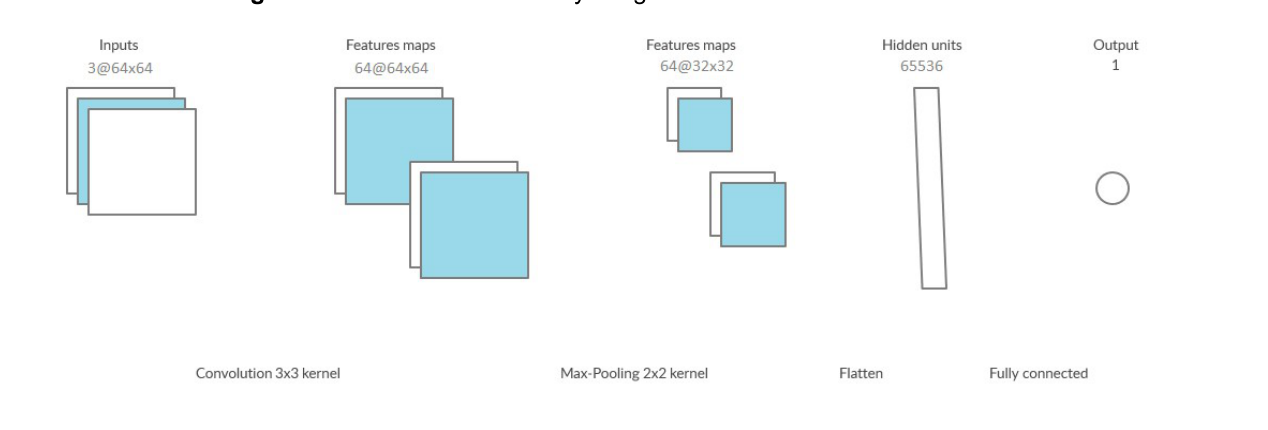
Figure 2. A shallow convolutional Neural Network